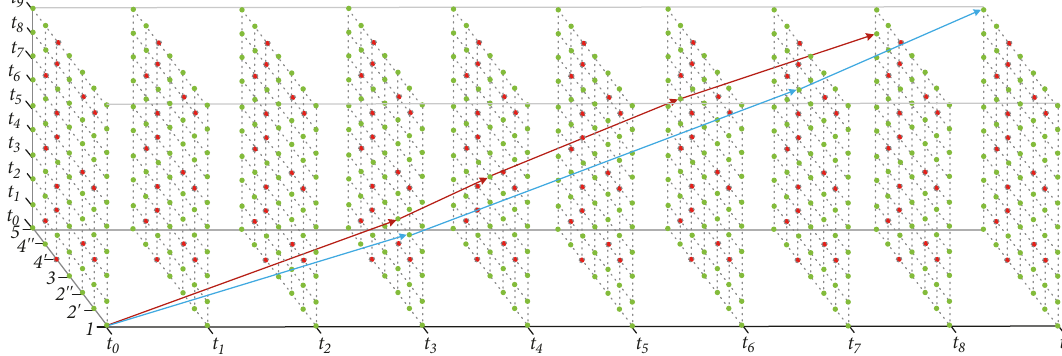
Figure 6: The simplified illustrative example of state-space-time trajectory.